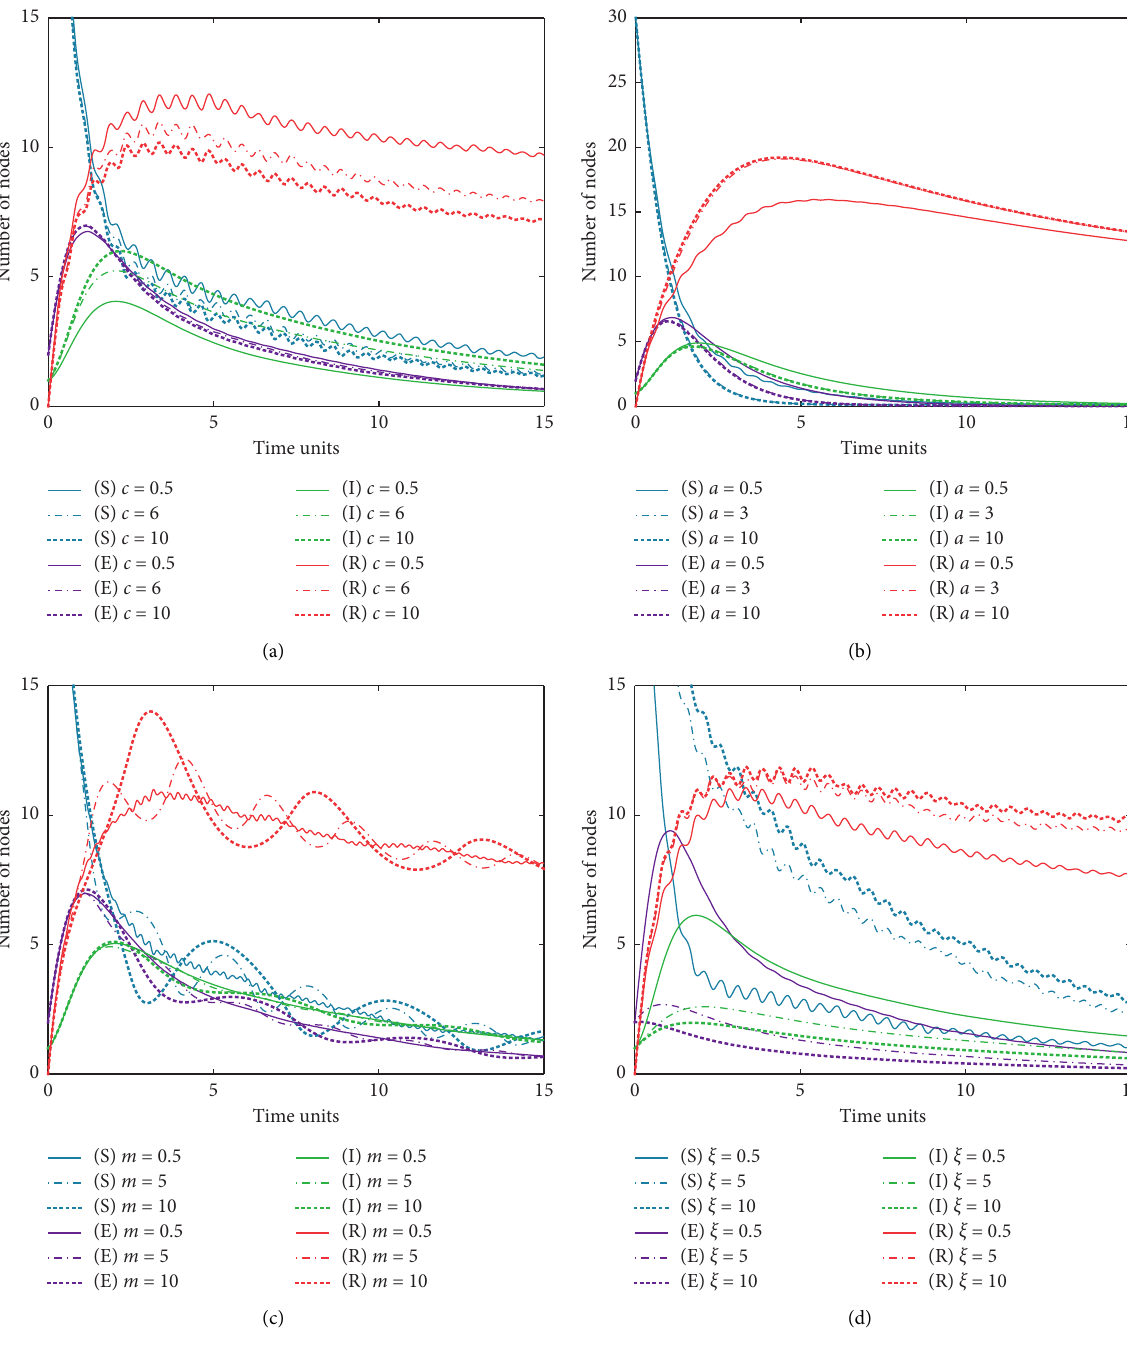
Figure 5: Simulation of the MalSEIRS model varying at different constants and rates (Cont’d). (a) Variation of the constant c used in the recovery rate c ( t ) . (b) Variation of the constant a used in the loss of immunity rate ω ( t ) . (c) Variation of the constant m used in the loss of immunity rate ω ( t ) . (d) Variation of the constant ξ used in the infection rate β ( t )